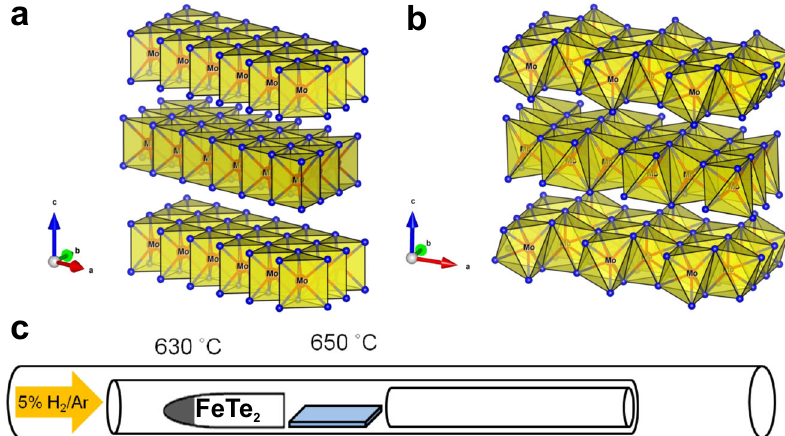
Fig. 1 Polymorphs of MoTe 2 and CVD setup. Crystal structure and polyhedral coordination of 3-layered hexagonal 2H-MoTe 2 ( a ) and monoclinic 1 T ′ -MoTe 2 ( b ); A schematic of the CVD setup employed in this work ( c ). The temperatures of 630 °C and 650 °C stand for the temperature of the precursor source and substrate,